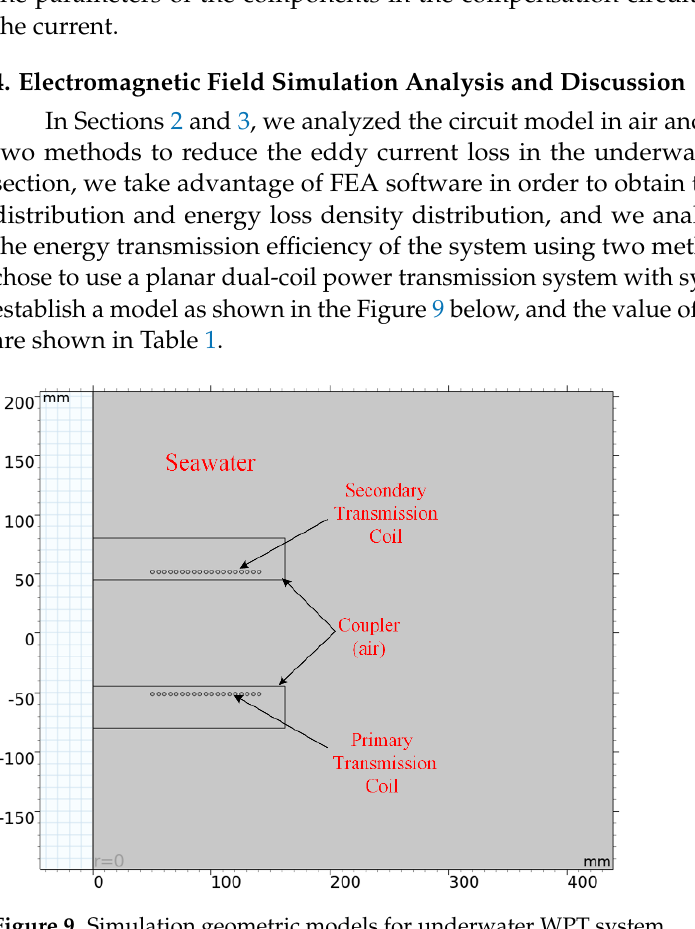
Figure 9. Simulation geometric models for underwater WPT system. Table 1. The meanings and value of parameters in simulation.